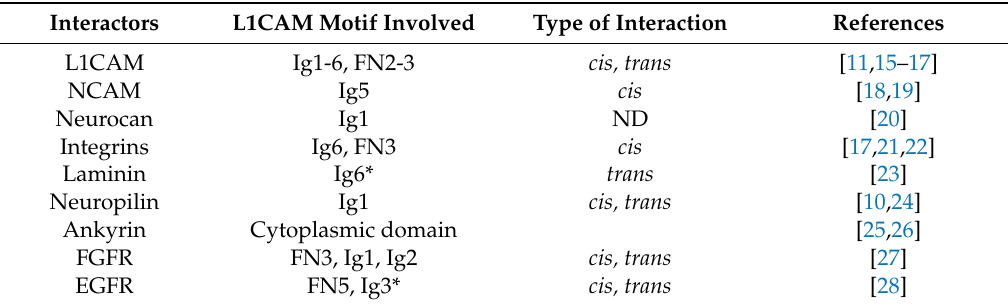
Table 1. Homophilic and heterophilic L1CAM interactors. ND = not defined. *not conclusively demonstrated but inferred from the data provided in the corresponding